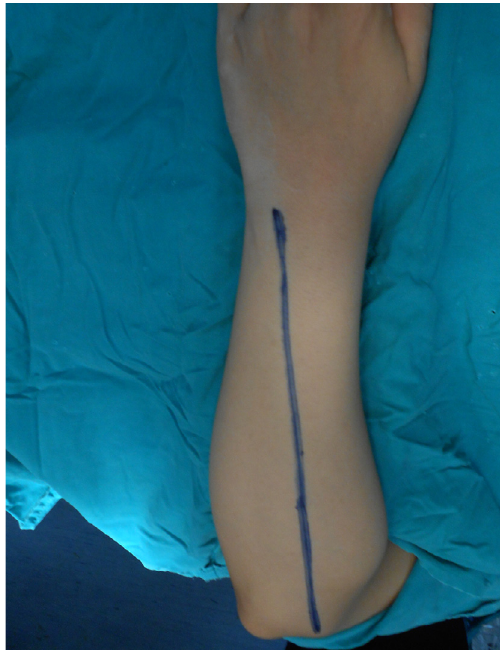
Figure 1. An intraoperative photograph demonstrating the incision in a straight line extending from the lateral humeral epicondyle to the ulnar